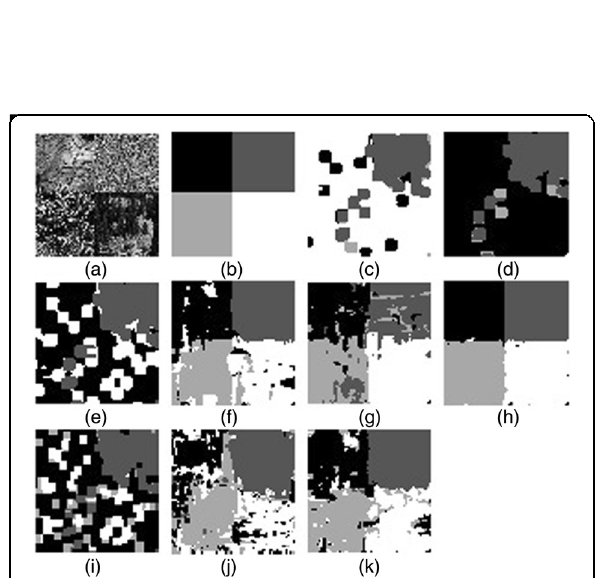
Fig. 27 Segmentation results for a mosaic from Vistex album without noise. a Original image. b Hand-segmented image. c Gaussian features. d Rayleigh features. e Alpha-stable features. f Gaussian + contourlet features. g Rayleigh + contourlet features. h Alpha-stable + contourlet features. i Fractal dimension. j Fractal + contourlet. k Alpha-stable + wavelet